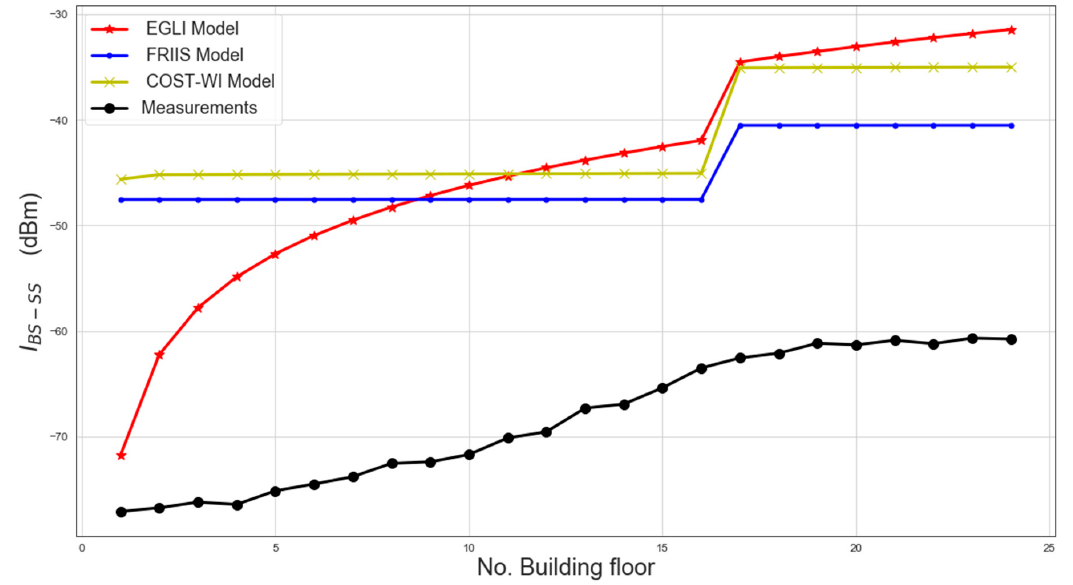
Figure 8. Simulated and measured power levels received in the long building.